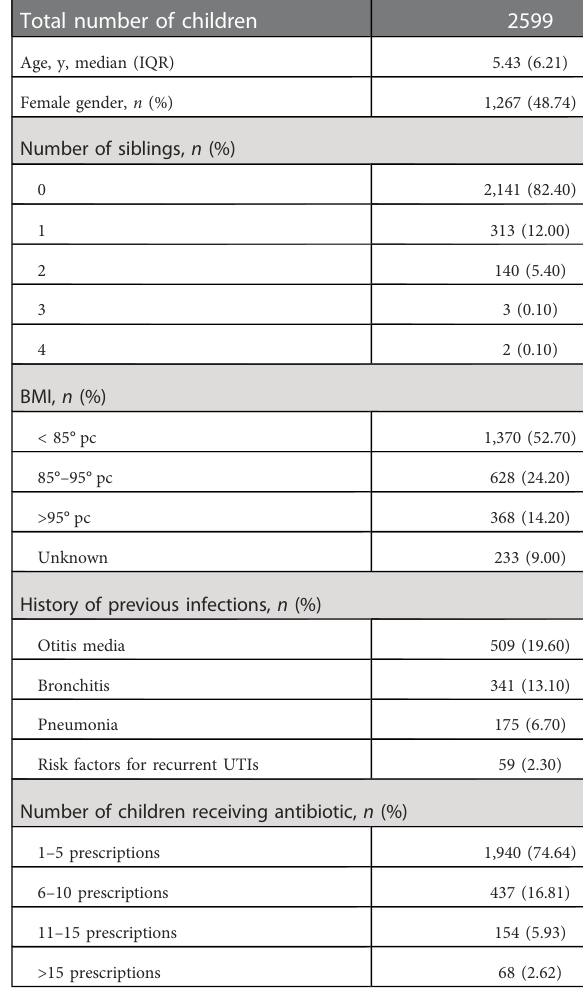
TABLE 2 Descriptive analysis of